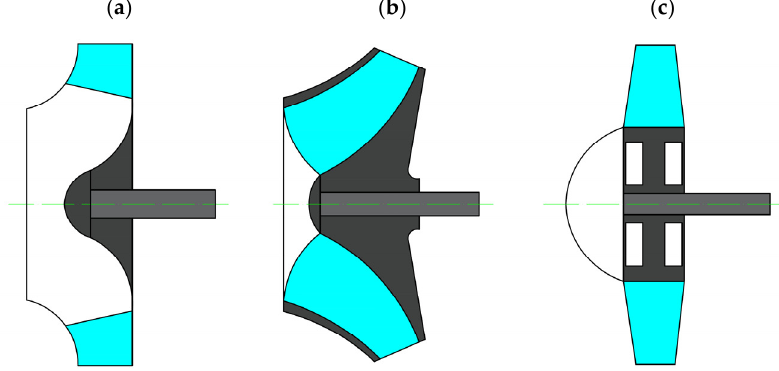
Figure 1. Fan impellers: with radial ( a ), diagonal ( b ), and axial flow ( c ).